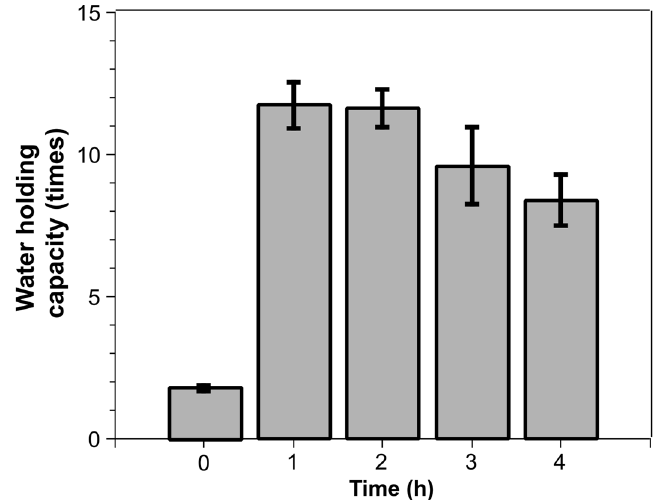
Figure 2. Water holding capacity of filter paper (FP) and samples treated with 7 wt% NaOH/12 wt% urea for 1, 2, 3 and 4 h.